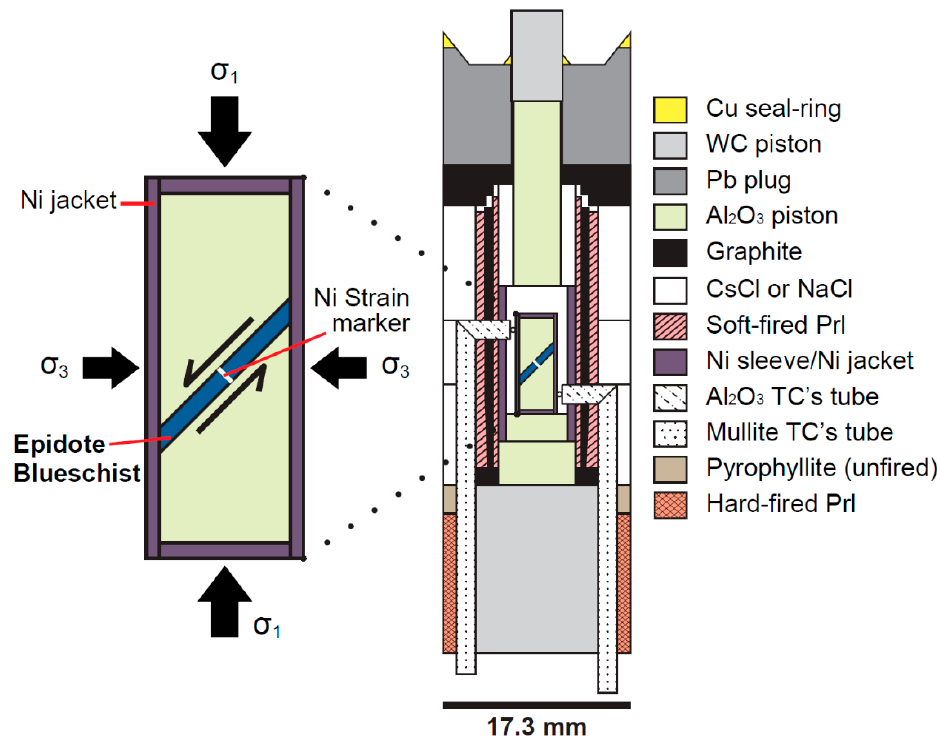
Figure 2. Schematic of sample assembly for the deformation experiment in simple shear. The sample was positioned at 45° to the maximum principal stress ( σ 1 ). A strain marker was placed perpendicular to the shear plane in the middle of the sample.